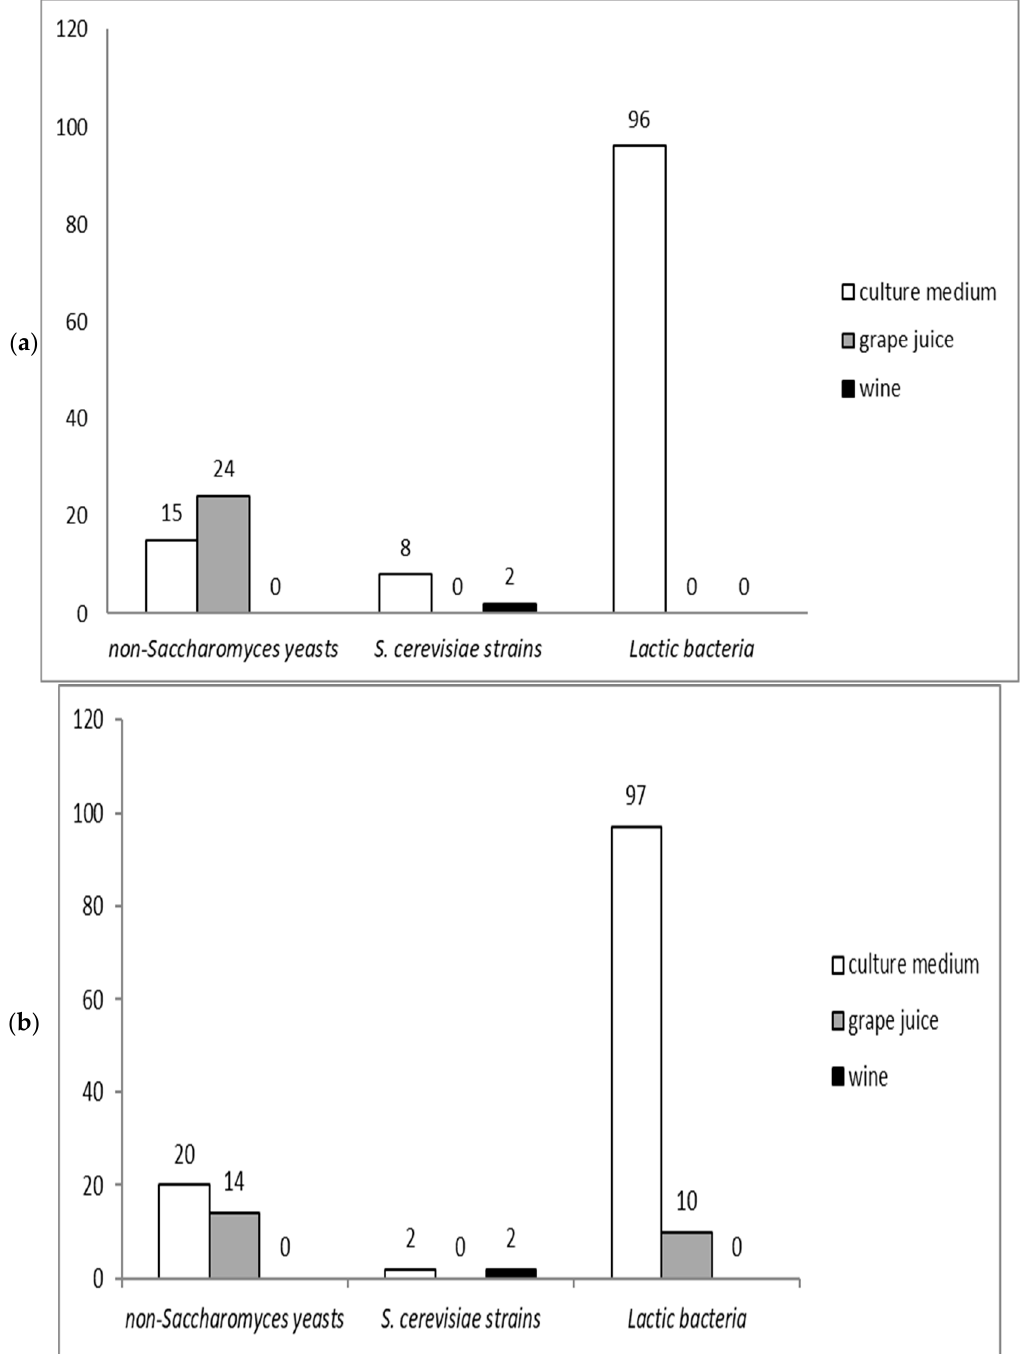
Figure 1. Frequency of inhibitory activity concerning the inhibiting ( a ) and inhibited ( b ) species, according to the different media tested.